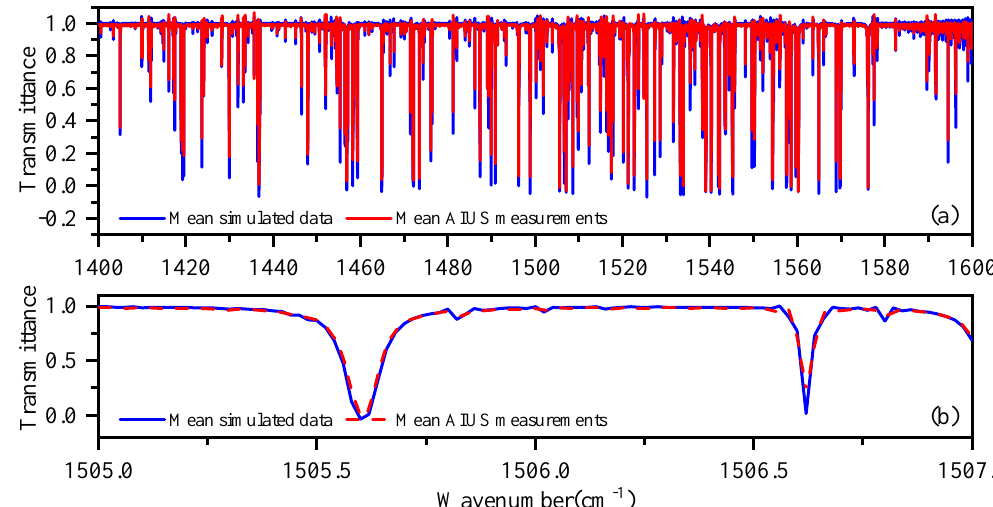
Figure 5. Mean transmittance of AIUS measurements and simulations in 1400–1600 cm − 1 at 40 km.